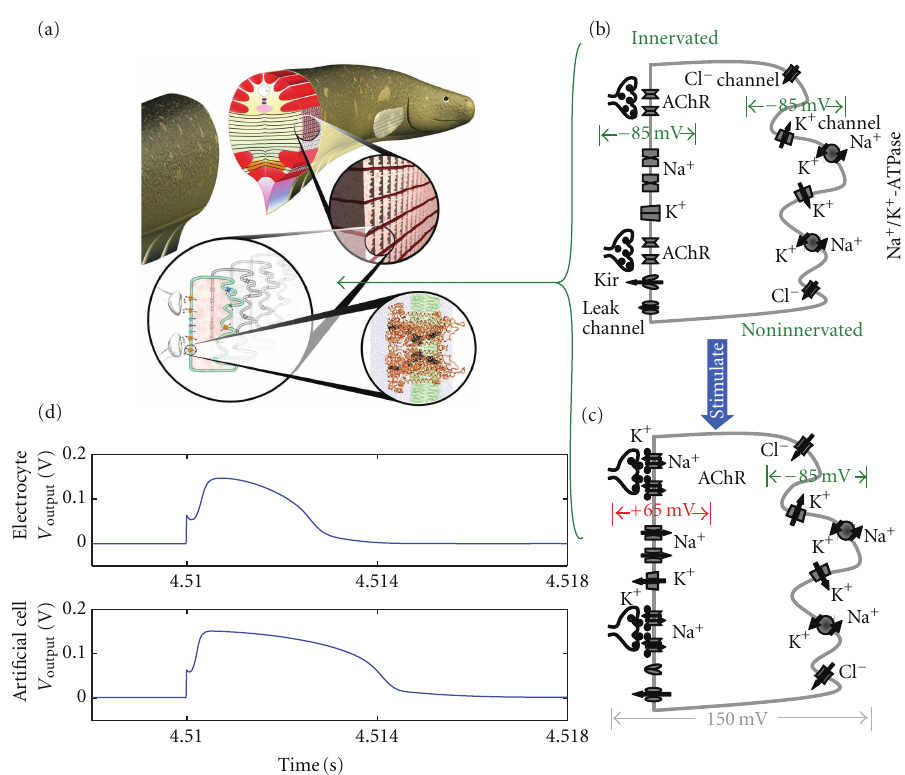
Figure 1: The electrogenic mechanism and performance of a protocell with AC output. (a) The anatomy of the electric eel [1]. (b) and (c) The electrocyte in the resting and the stimulated stage [1]. (d) The calculated voltage outputs of the electrocyte and the optimally configured artificial